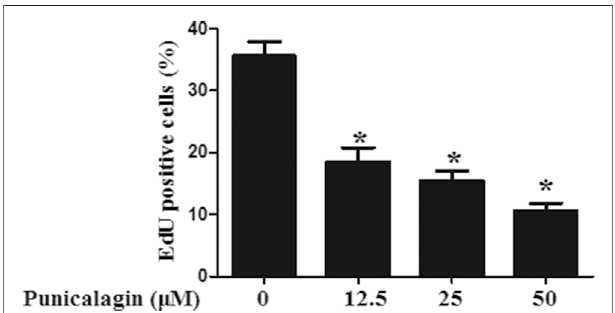
FIGURE 7 | Inhibitory effect of punicalagin on proliferation of HUVECs. The histogram represents the percentage of positive cells in the total cells under the microscope. Values are represented as mean ± SD. * p < 0.05, punicalagin treatment vs. control group.